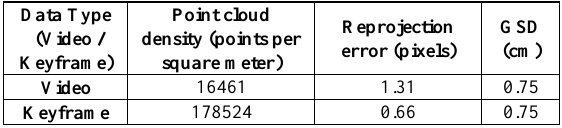
Table 6. The output results of the thermal infrared dense point cloud generation for the evaluation